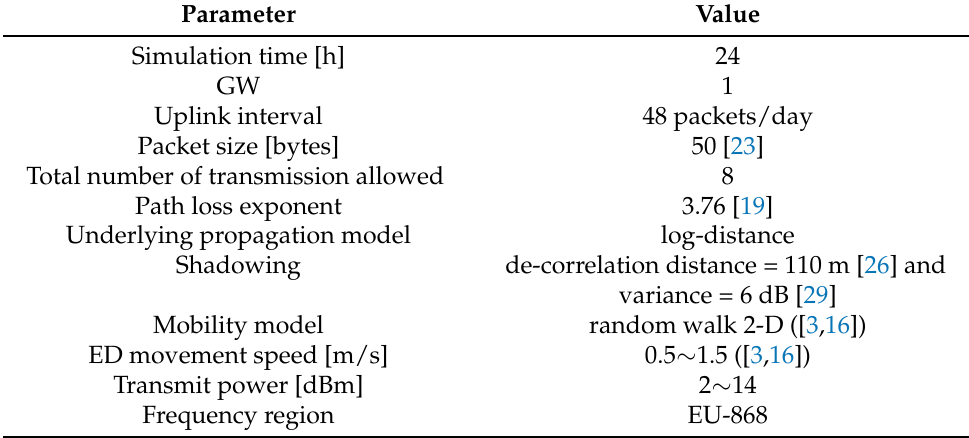
Table 5. Simulation